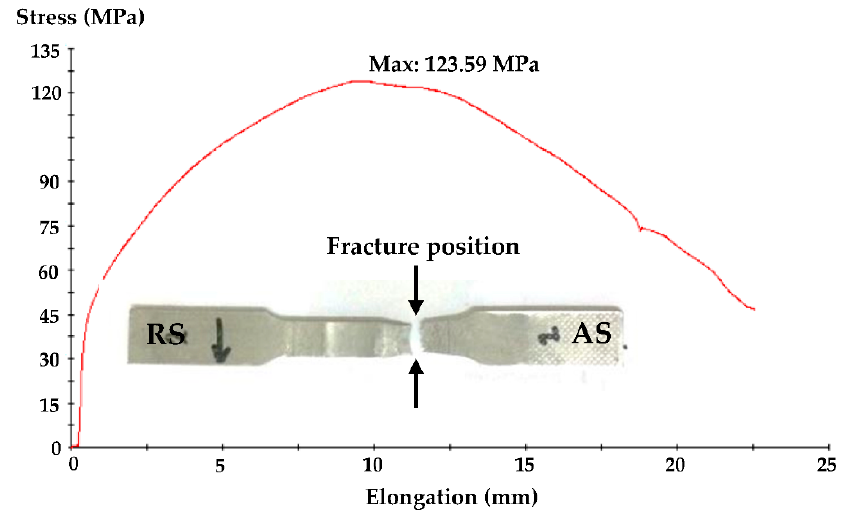
Figure 6. The stress–strain of the welded joint on FSWp of SSM 6063 aluminum alloys.